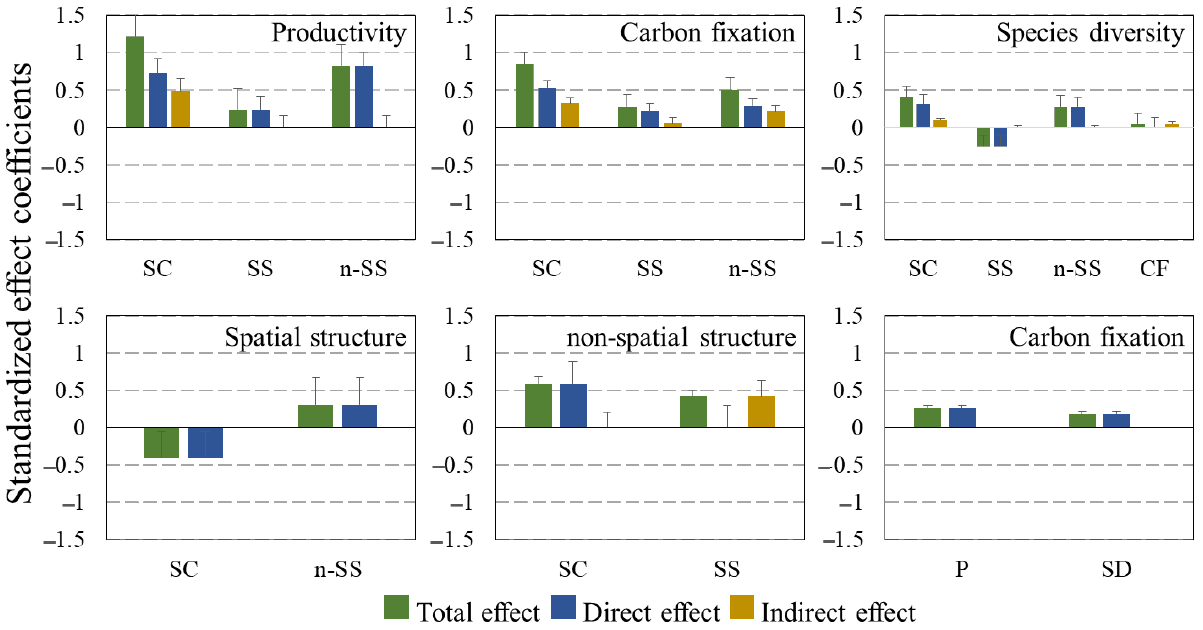
Figure 3. Standardized total, direct and indirect effects of site conditions, spatial structure and non-spatial structure on forest functions. (SC is site conditions, SS is spatial structure, n-SS is non-spatial structure, CF is carbon fixation, P is productivity, SD is species diversity.)